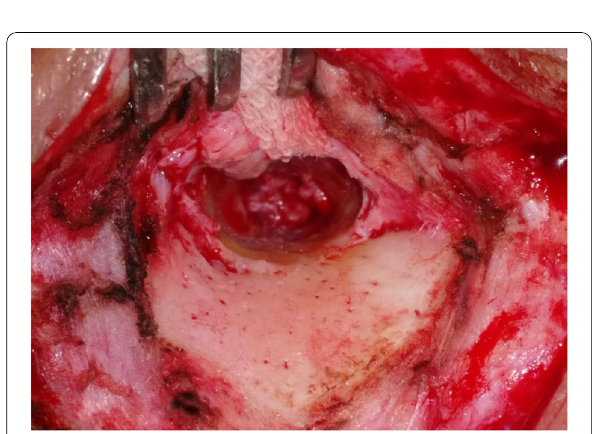
Fig. 1 Pre canaloplasty image showing superior bony overhangs (Right ear)